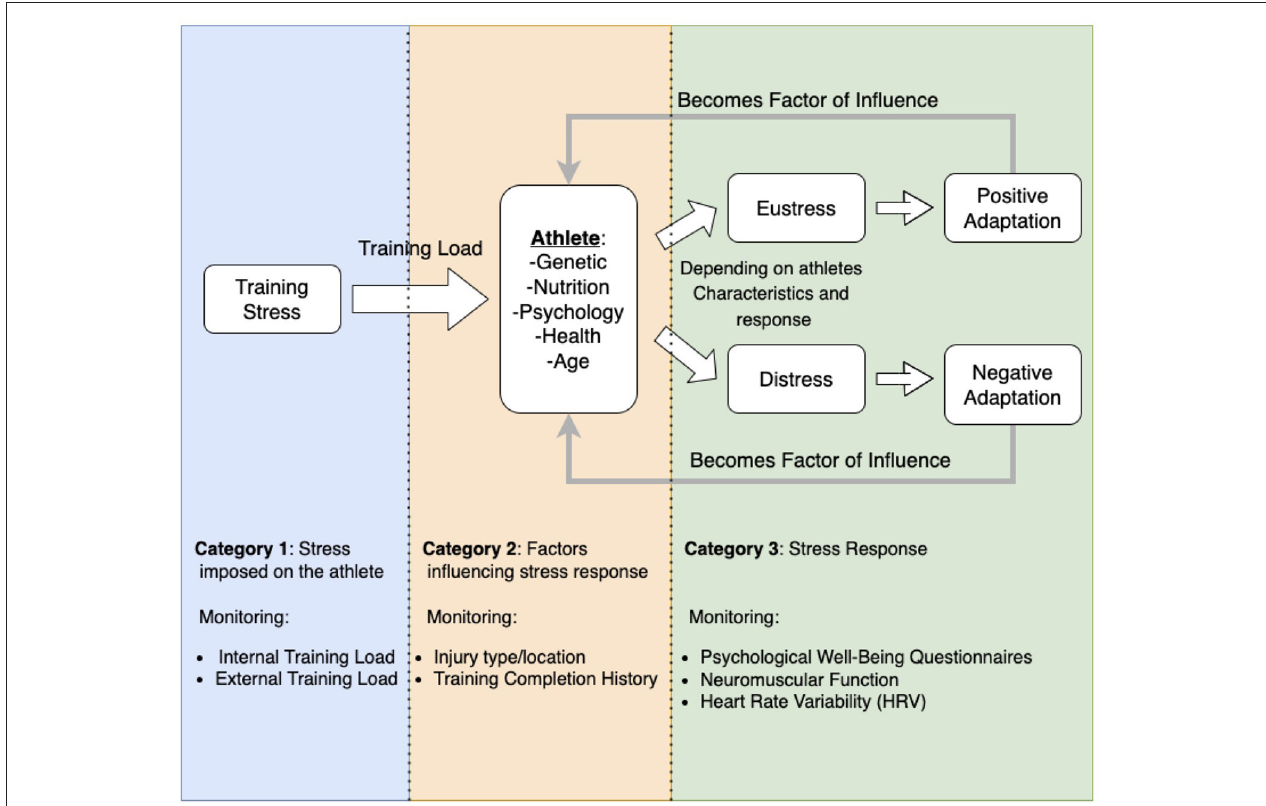
FIGURE 2 | Conceptual framework of the factors influencing sport performance and injuries and their